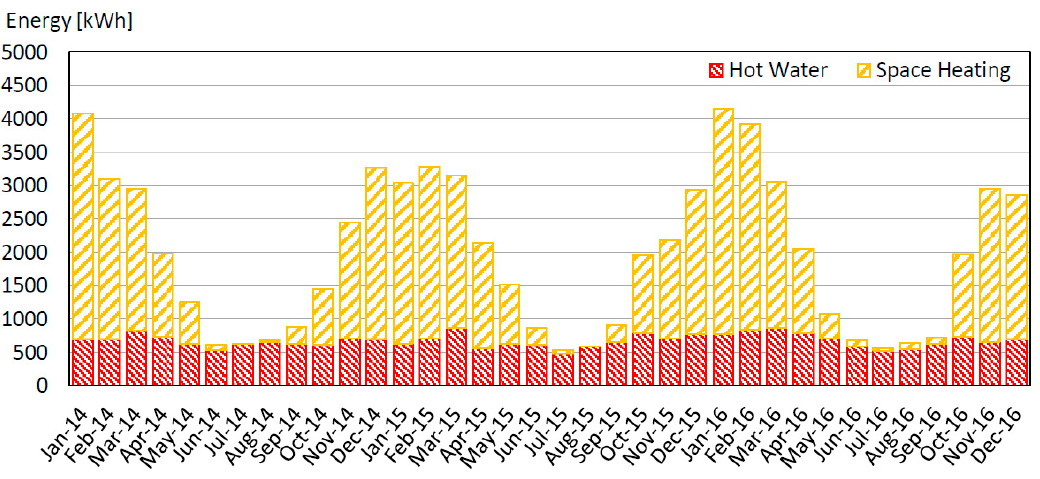
Figure 12. Measured monthly heating and hot water loads.